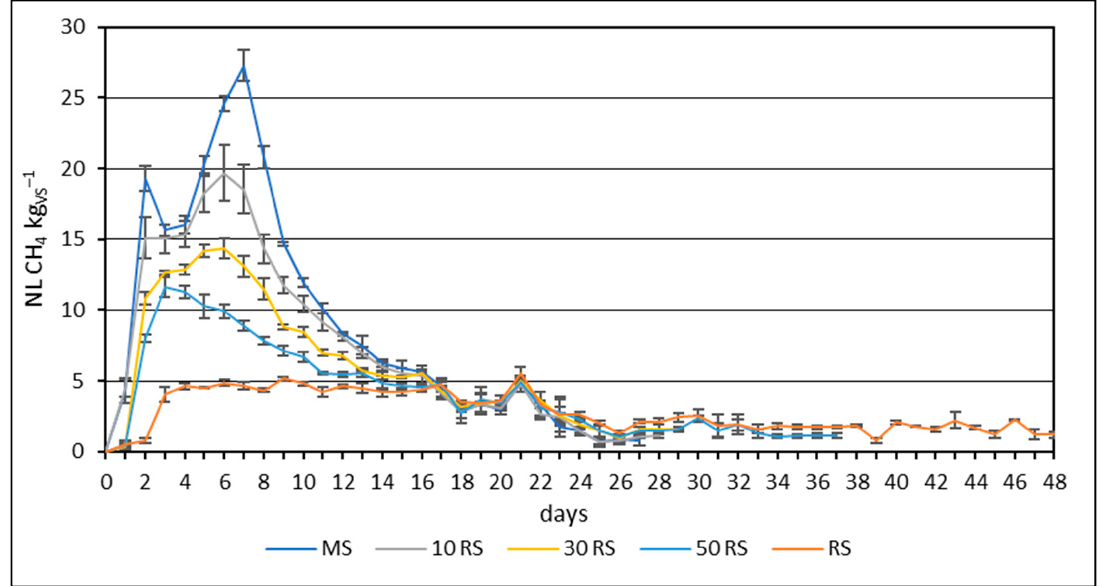
Figure 2. Daily methane production from mono- and co-digestion of maize and reed silages. MS—maize silage, 10 RS—maize silage with 10% content of reed silage, 30 RS—maize silage with 30% content of reed silage, 50 RS—maize silage with 50% content of reed silage, and RS—reed silage. Standard errors are shown as vertical bars.